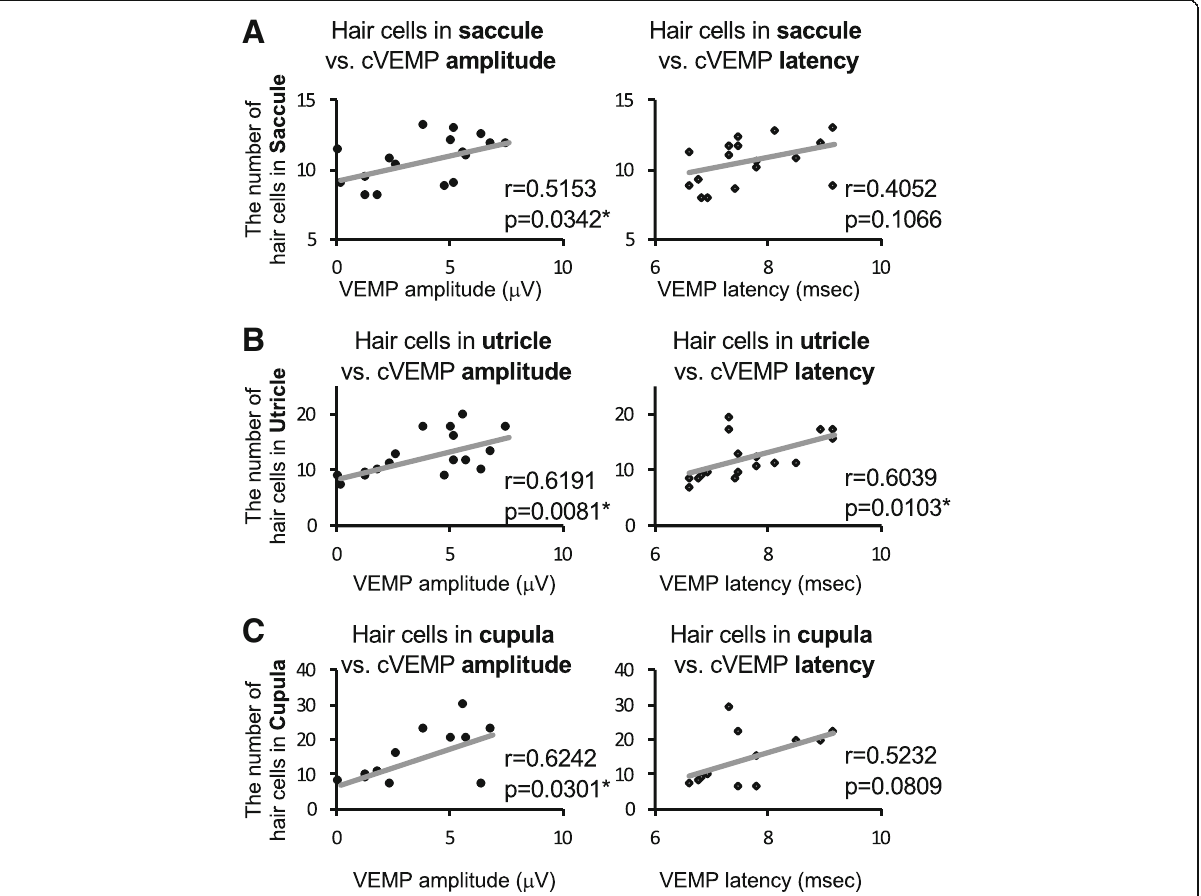
Fig. 5 Correlations between the numbers of hair cells and cVEMP results. a – c Correlations of the numbers of hair cells in the saccule ( a ), utricle ( b ), and cupula ( c ) with cVEMP amplitude [microvolts ( μ V), left graphs] and VEMP latency (msec, right graphs) are shown. Triplicated measurements for cVEMP with a total of 6 mice including 3 mice for the control group and 3 mice for the IDPN group were performed. Spearman ’ s rank correlation coefficients and significance differences (* p <0.05) were analyzed for a hair cells in the saccule vs. cVEMP amplitude [ r =0.5153, p =0.0342] and cVEMP latency [ r =0.4052, p =0.1066], b hair cells in the utricle vs. cVEMP amplitude [ r =0.6191, p =0.0081] and cVEMP latency [ r =0.6039, p =0.0103], and c hair cells in the cupula vs. cVEMP amplitude [ r =0.6242, p =0.0301] and cVEMP latency [ r =0.5232, p